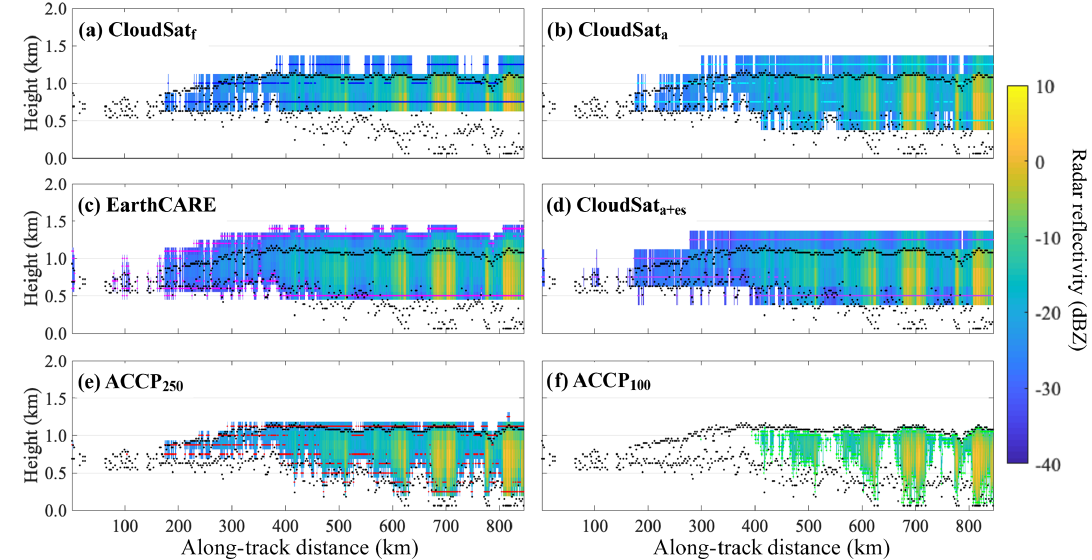
Figure 6. Based on KAZR observations of the hydrometeor layer of 27 February 2016, forward-simulated radar reflectivity (colormap) and estimated hydrometeor layer boundaries (colored dots) for (a) CloudSat f (royal blue dots), (b) CloudSat a which is CloudSat operating with the EarthCARE asymmetrical range-weighting function (cyan dots), (d) CloudSat a + es which alternatively has an enhanced sensitivity equivalent to the EarthCARE (purple dots), (c) EarthCARE which additionally operates with a factor of 5 vertical oversampling (magenta dots), (e) ACCP 250 which instead has a 250m range resolution (red dots) and (f) ACCP 100 which instead has a 100m range resolution (green dots). For reference, the corresponding KAZR-observed radar reflectivity is depicted in Fig. 1a and echo boundaries identified by the KAZR are overlaid on each subpanel using black